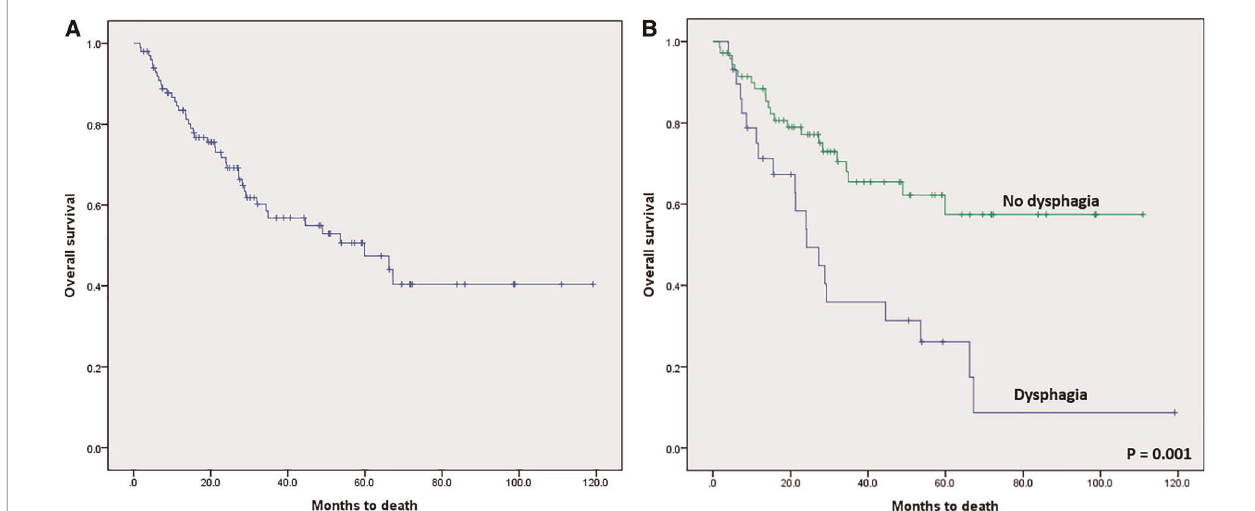
FIGURE 3 | Kaplan – Meier survival curves. ( A ) Overall survival (OS) after curative surgical treatment for hypopharyngeal cancer. The median overall OS was 59.9 months, and the 5-year OS was 47.5%. ( B) Kaplan-Meier survival curve comparing the patients with dysphagia and patients without dysphagia after curative surgical treatment in hypopharyngeal cancer (log-rank test; p